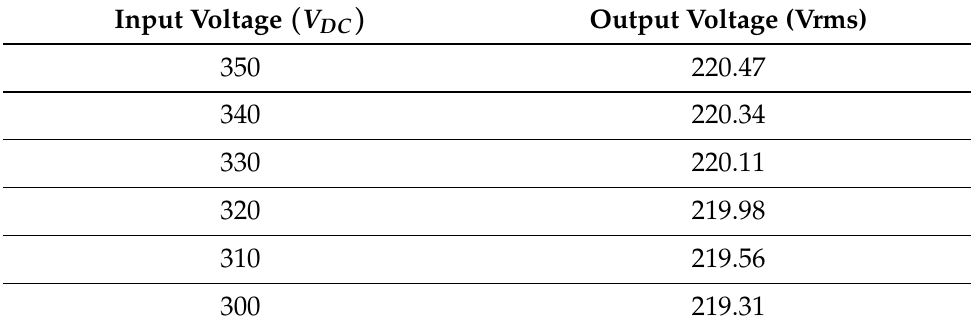
Table 5. Input Voltage